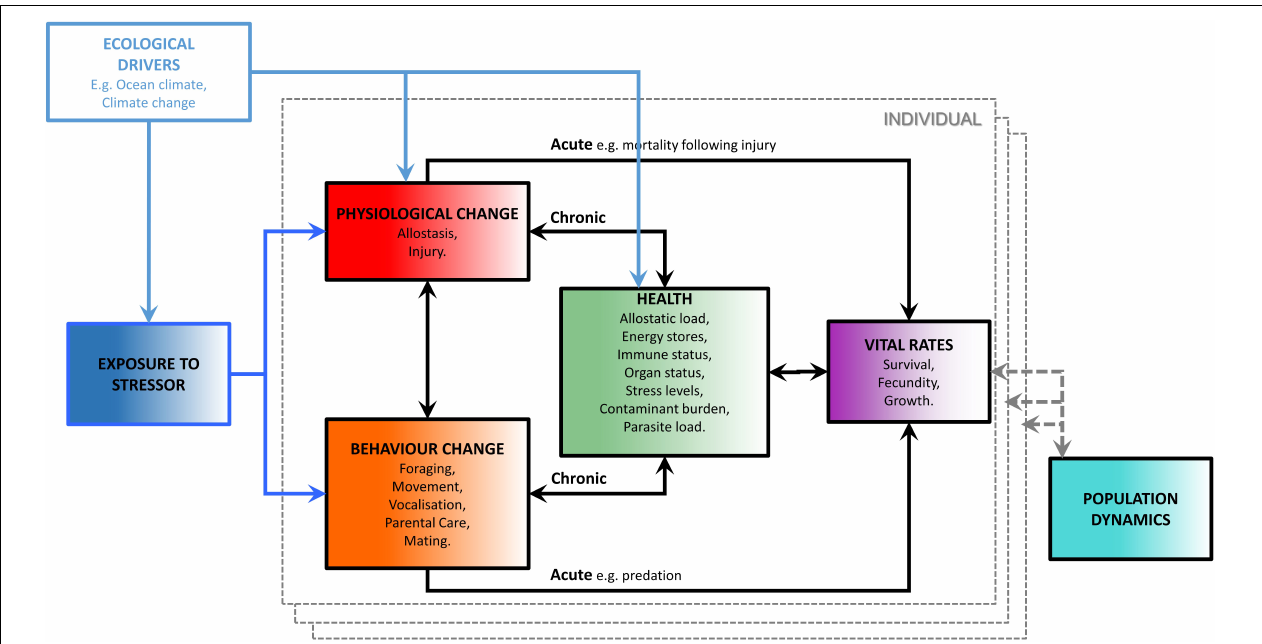
FIGURE 1 | “The Population Consequences of Disturbance (PCoD) conceptual framework, the boxes within the dashed gray boundary line represent the effects of exposure to a stressor and a range of ecological drivers on the vital rates of an individual animal. The effects are then integrated across all individuals in the population to project their effects on the population’s dynamics” [reproduced from Pirotta et al.